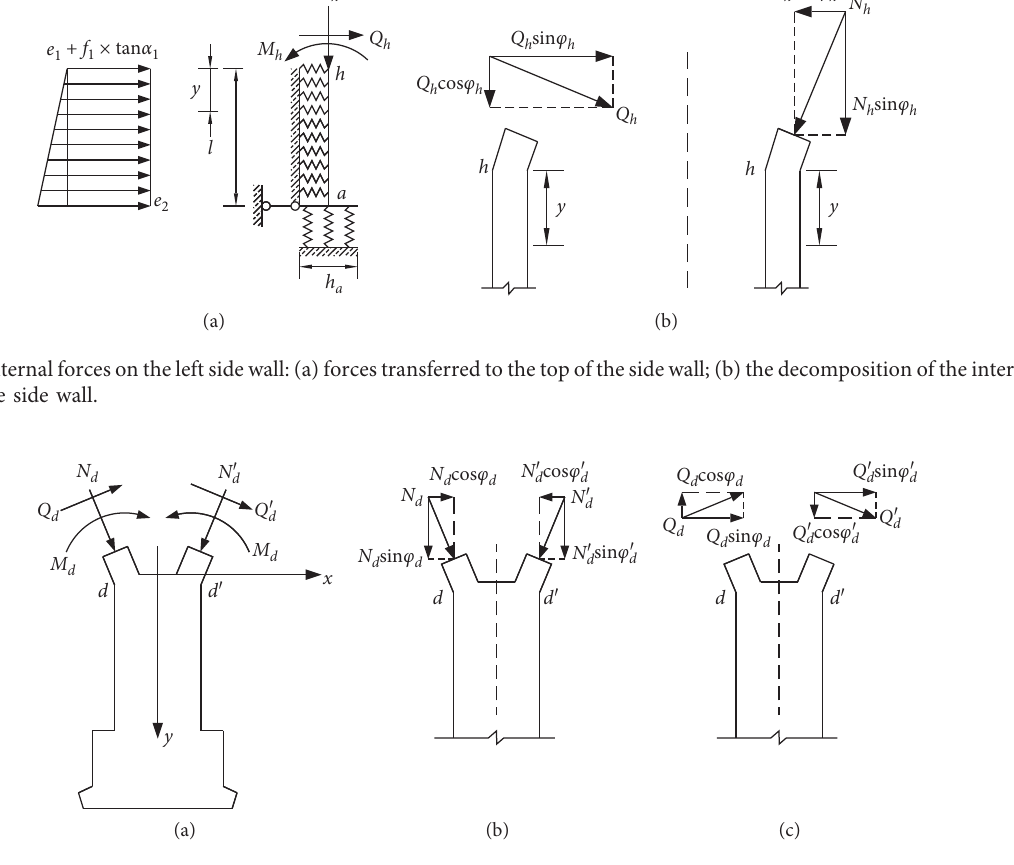
Figure 6: The forces and decompositions at the top of the middle